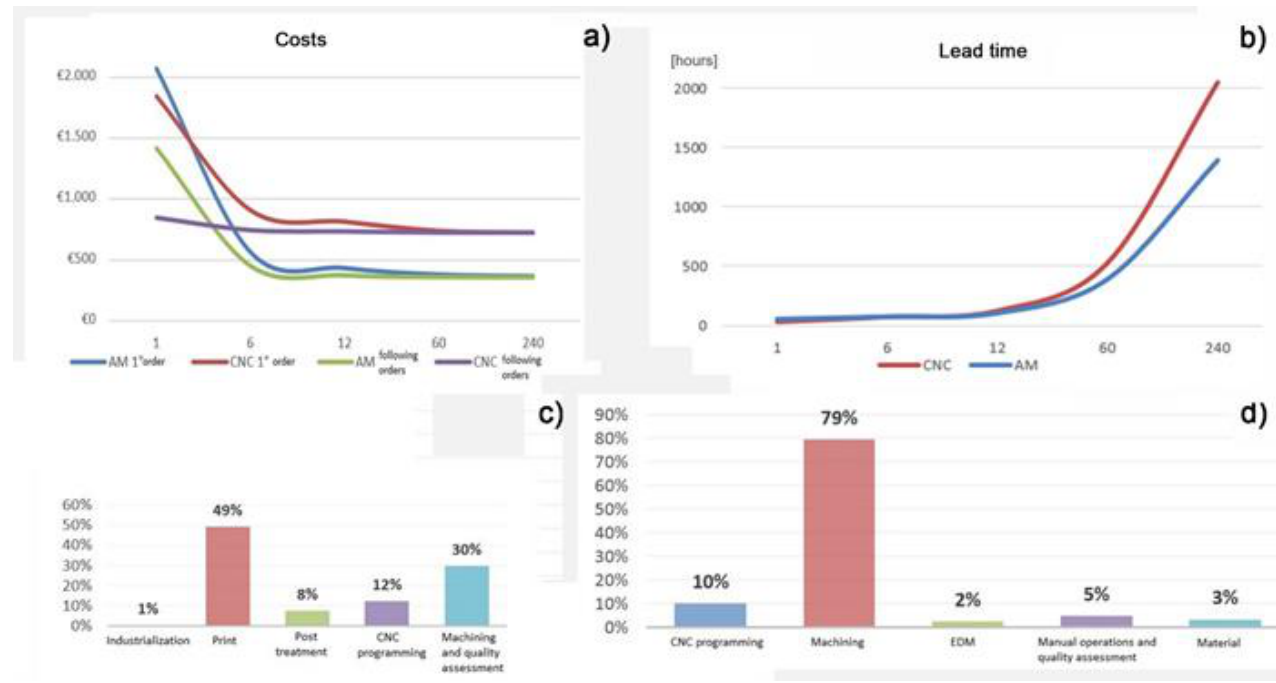
Figure 5. Direct comparison between LPBF + CNC and CNC alone in terms of cost per part ( a ) and lead-time ( b ) as a function of the production volume. Costs ( a ) are specified for first orders and for reorders. Single contributions to the cost per part for LPBF + CNC ( c ) and for CNC alone ( d ).